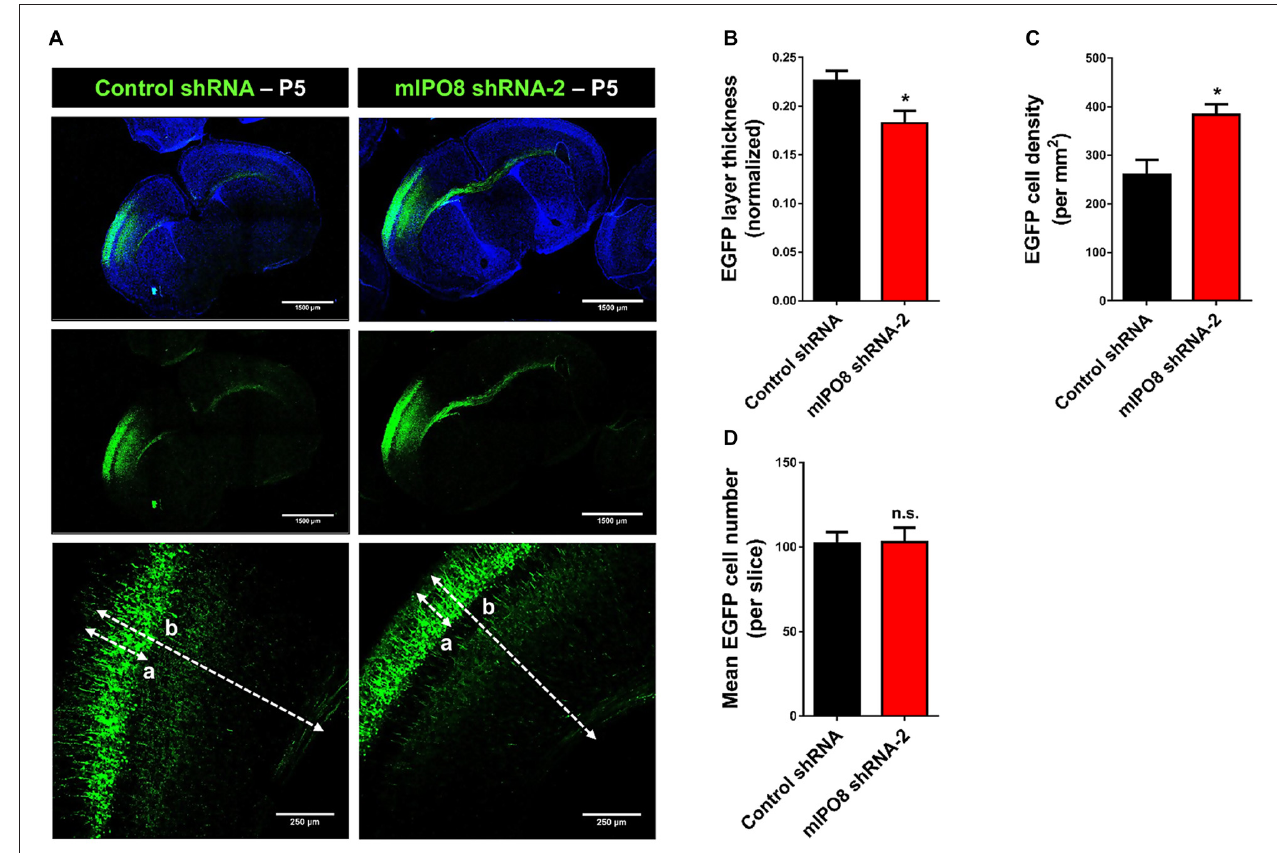
FIGURE 4 | Long term Ipo8 knockdown delayed radial migration of projection neurons. (A) Radial migration after long term Ipo8 mRNA knockdown. Distribution of EGFP-positive cells at P5 i.e., 9 days after IUE at E14.5 of a plasmid co-expressing EGFP and either a control shRNA or mIPO8 shRNA-2. The dashed lanes “a” and “b” correspond to the thickness of the EGFP layer and of the cortex respectively. (B–D) Normalized thickness, mean number of neurons and neuronal density of the EGFP layer. The normalized layer thickness corresponds to the a/b ratio. ∗ p <